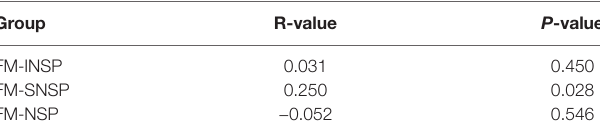
TABLE 10 | Inter-group differences of community structure based on Anosim method.